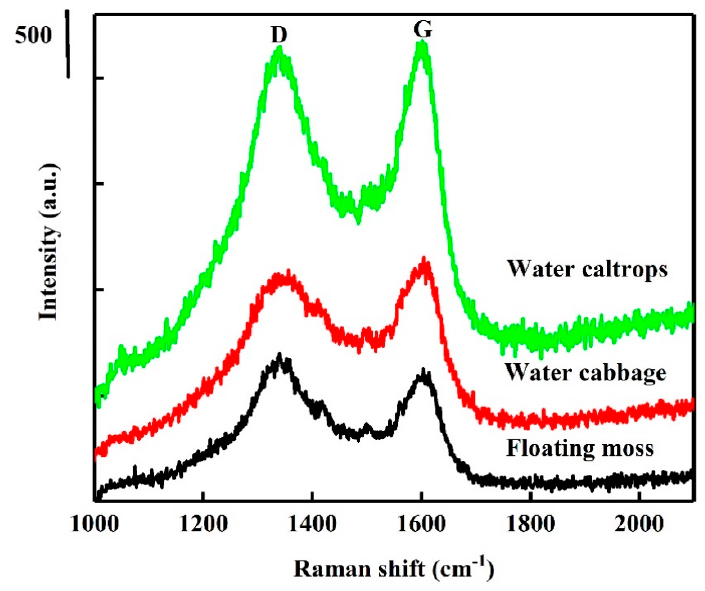
Figure 2. Raman spectra of the silicon oxycarbide (SiOC) samples.